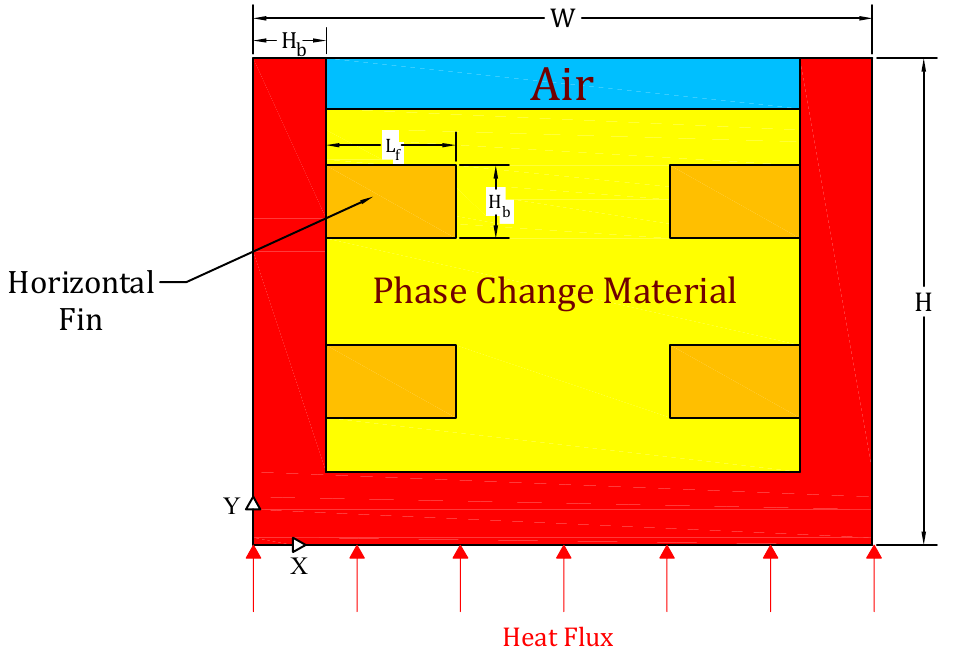
(cid:17) (cid:16) L f × H b .